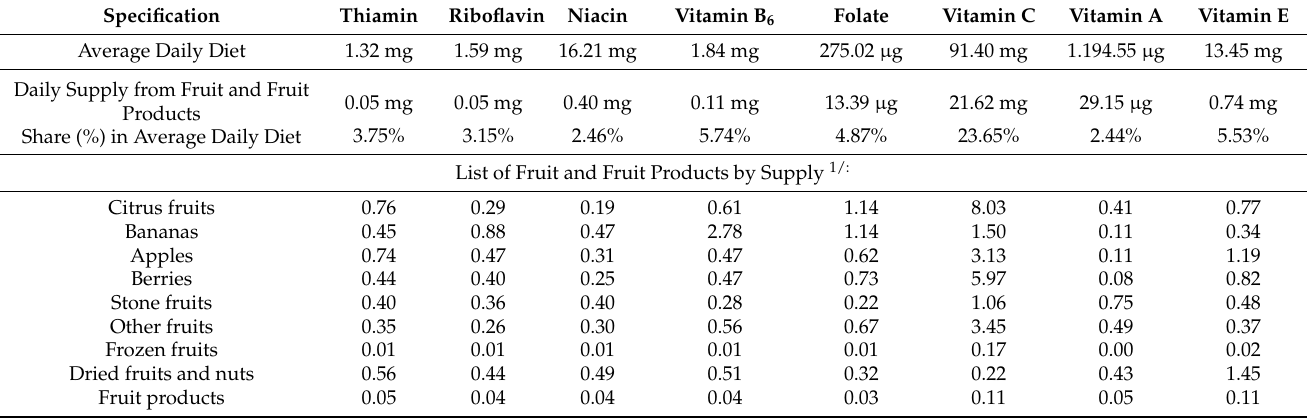
Table 3. Supply of vitamins from fruit and fruit products.